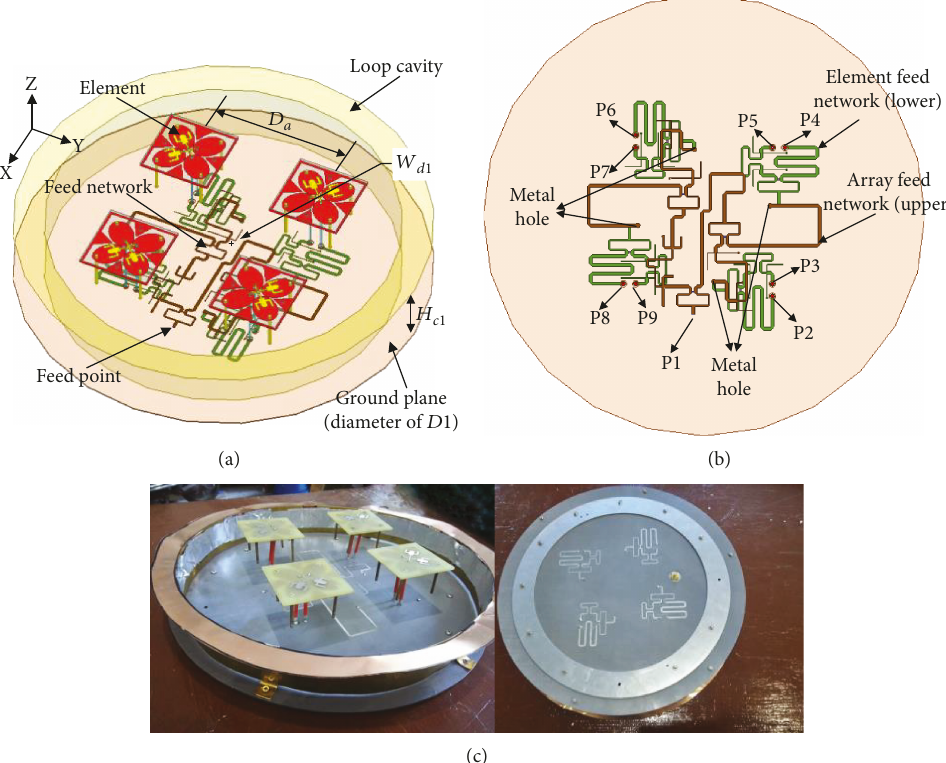
Figure 9: Con fi guration of the proposed antenna array. (a) 3D view. (b) Feed network. (c)